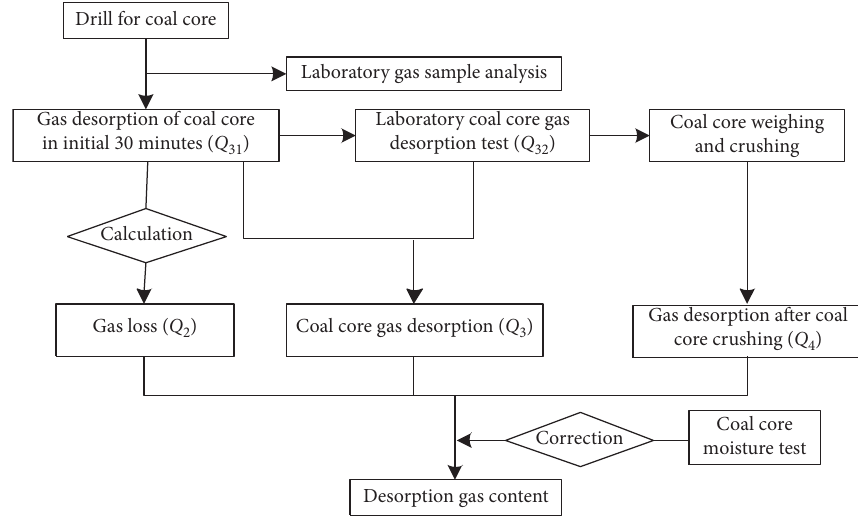
Figure 2: Gas content test